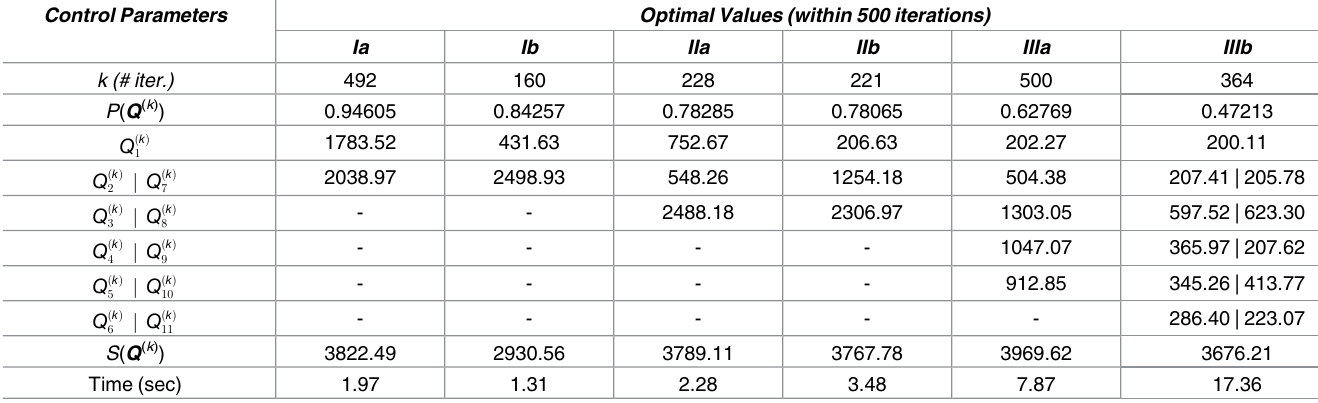
Table 5. ALOPEX pumping management performance: Optimal Parameter Values. Control